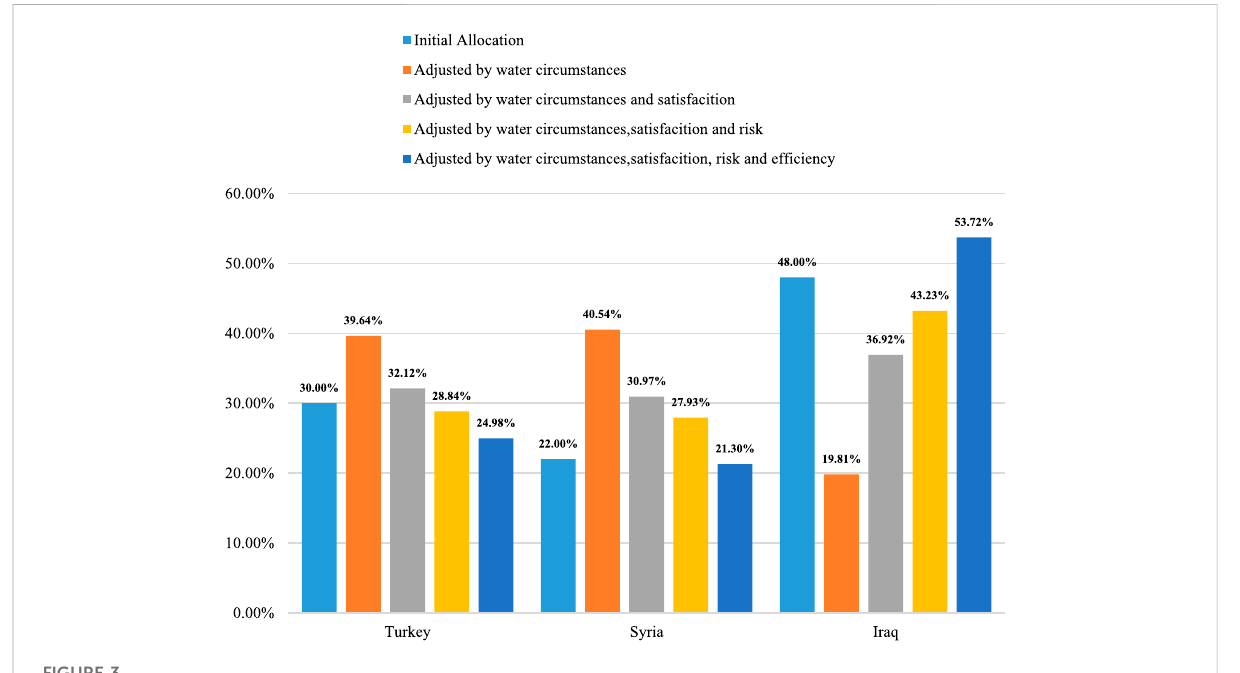
FIGURE 3 Comparison of the allocation adjustments based on different coef fi cients.